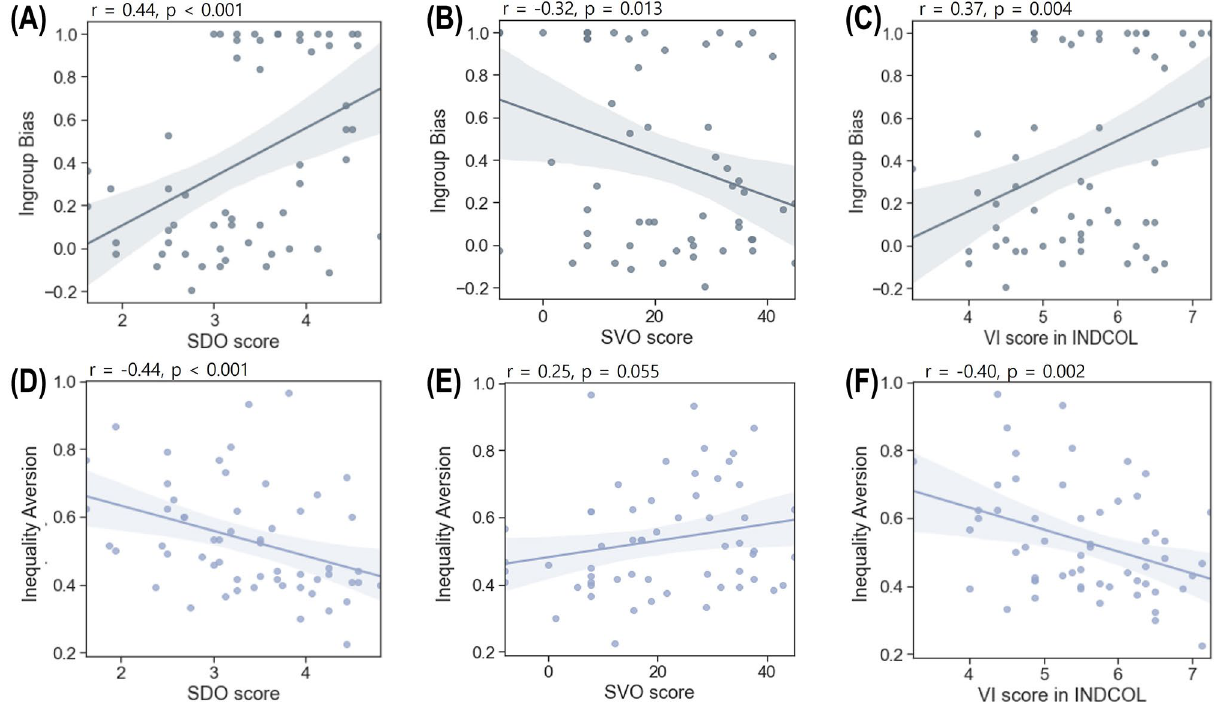
Figure 4. Individual differences in personality traits predicting ingroup bias and inequality aversion measured by the BIDG. ( A ) Individuals with higher ingroup bias parameters showed higher SDO scores, ( B ) lower SVO scores, and ( C ) higher VI scores. ( D ) Individuals with higher inequality aversion parameters showed lower SDO scores, ( E ) higher SVO scores with marginal significance, and ( F ) lower VI scores. the results are based on two- tailed Pearson correlation analyses and the line shadow indicates the 95% confidence